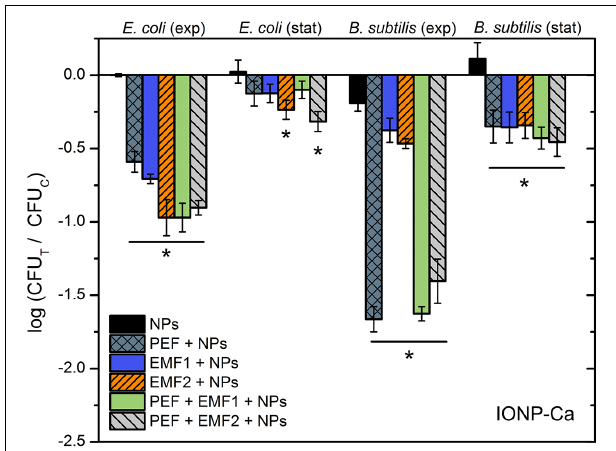
FIGURE 5 | Inactivation of E. coli and B. subtilis using different treatment protocols and nisin-unloaded iron oxide NP with Ca as a capping agent (IONP-Ca), where PEF – 10 kV cm − 1 × 8 × 100 µ s; EMF1 – 3.3 T × 50, 0.25 Hz; EMF2 – 10 mT, 100 kHz, 2 min. The number of residual culturable cells in the samples after the PEF treatment (CFU T ) was compared with ones in the control samples without treatment (CFU C ). The asterisk ( ∗ ) represents statistically significant ( P < 0.05) difference versus NPs only treatment.